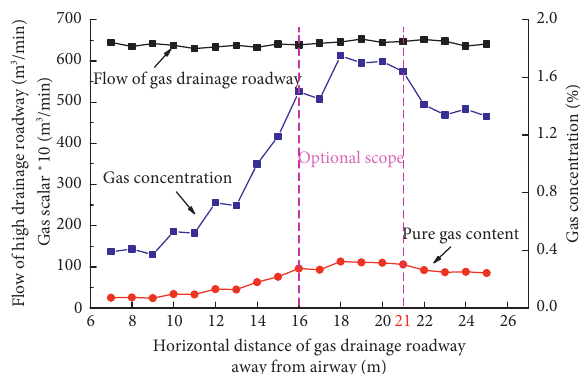
Figure 12: Drainage parameters versus the horizontal distance of the GDR in 1211working